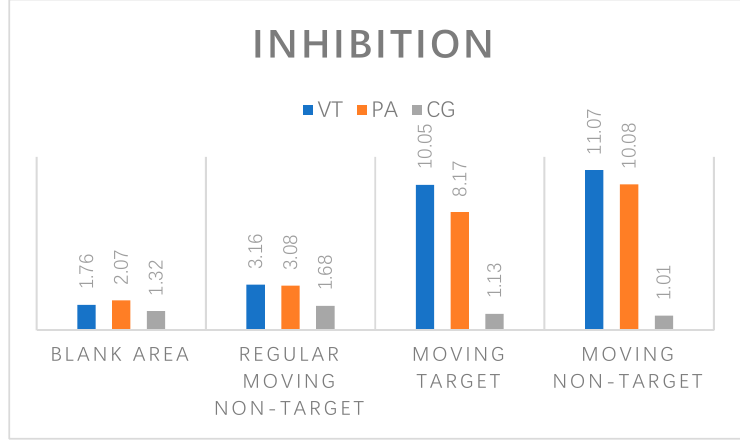
Figure 3. Comparison of the inhibition of different groups in four positions.